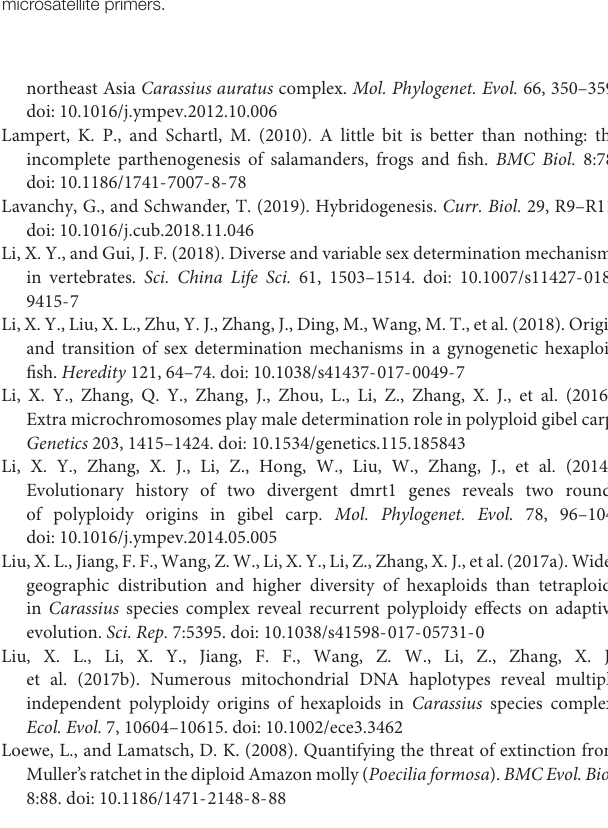
Supplementary Figure 1 | Histogram analyses of microchromosome number. (A,B) Microchromosome number in three male offspring (A) and three female offspring (B) from F mating with A + of GSD. (C) Microchromosome number in three female offspring from F mating with A + of TSD. (D) Microchromosome ♀ ♂ number in three female offspring from F mating with Cc . A total of 50 ♀ ♂ metaphases were counted for each tested individual. Number of ♀ ♂ microchromosomes is exhibited on the X -axis and the percentage of total cells is shown on the Y -axis. mating Supplementary Figure 2 | Microsatellite analysis in the families of F with A + of GSD, A + of TSD, and Cc . Microsatellite electrophoretic ♀ patterns amplified by the primer MFW1, MFW19, YJ0001, YJ0002, YJ0004, ♂ ♂ ♂ YJ0005, YJ0033, YJ0039, and YJ0042. : female; : male. Marker is pUC18 DNA/ Msp I. ♀ ♂ Supplementary Figure 3 | Sequence alignments of the electrophoretic bands with the same size in both paternal A + of GSD and corresponding offspring in Figure 3A . (A,B) Alignment of sequences amplified by primer MFW23 (A) and ♂ primer YJ0010 (B) between paternal individual A + of GSD and the corresponding individual in the offspring. (C,D) Alignment of long sequences (C) ♂ and short sequences (D) amplified by primer YJ0020 between the paternal individual A + of GSD and the corresponding individual in the offspring. Primers were exhibited on the left side. The forward and reverse primer sequences are ♂ indicated in red and blue rectangles, respectively. Supplementary Table 1 | Primer sequences and annealing temperature of genotypic male-specific marker. Supplementary Table 2 | Sequences and annealing temperatures of fifteen microsatellite